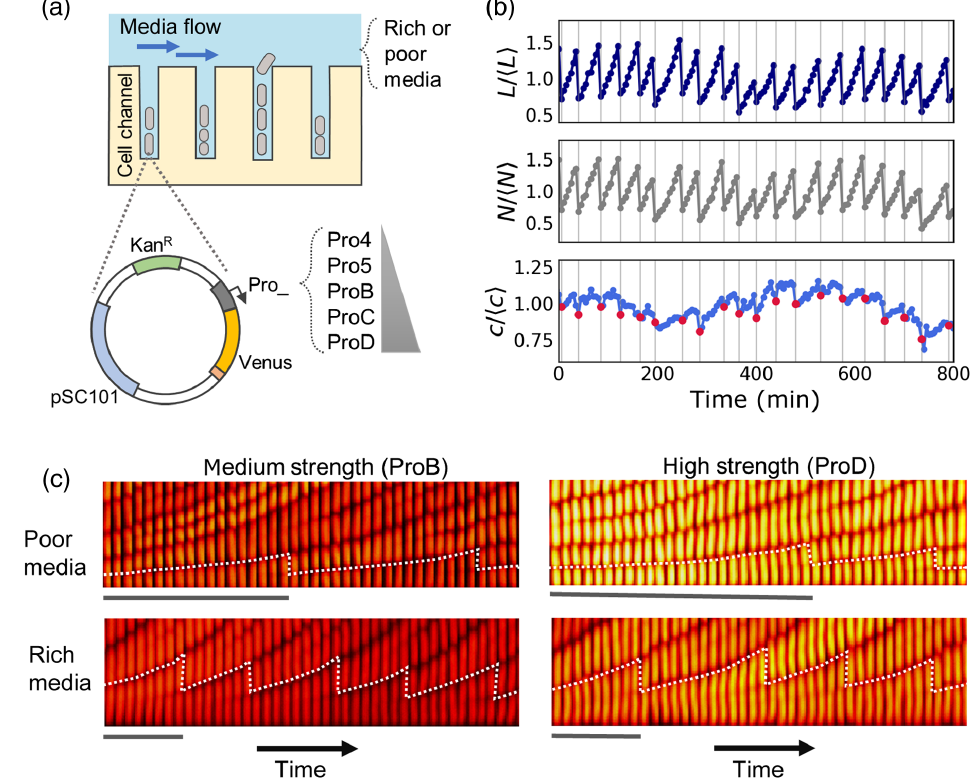
FIG. 1. (a) Schematics of the experimental setup. Using the microfluidic device mother machine and fluorescent microscopy, we monitor individual cells of various E. coli strains growing under a constant flow of either rich or poor media. Each strain contains a plasmid that codifies for the fluorescent protein Venus under the control of an artificial promoter from a set of promoters with increasing strengths, Pro f 4 ; 5 ; B; C; D g [19]. (b) Typical time traces of a single cell containing the ProB promoter and growing in rich medium: normalized cell length L (top), total fluorescence N (middle), and fluorescence density c ð¼ N=L Þ (bottom). The vertical lines and the red dots at the bottom plot indicate the times of cell division. (c) Kymographs illustrating the fluorescence level of strains with the promoters ProB (left) and ProD (right) controlling Venus expression, growing in poor (top) and rich (bottom) media. Each frame is separated from the following one by a time interval of 5 min. The bars below the kymographs show the span of a cell trace from birth until